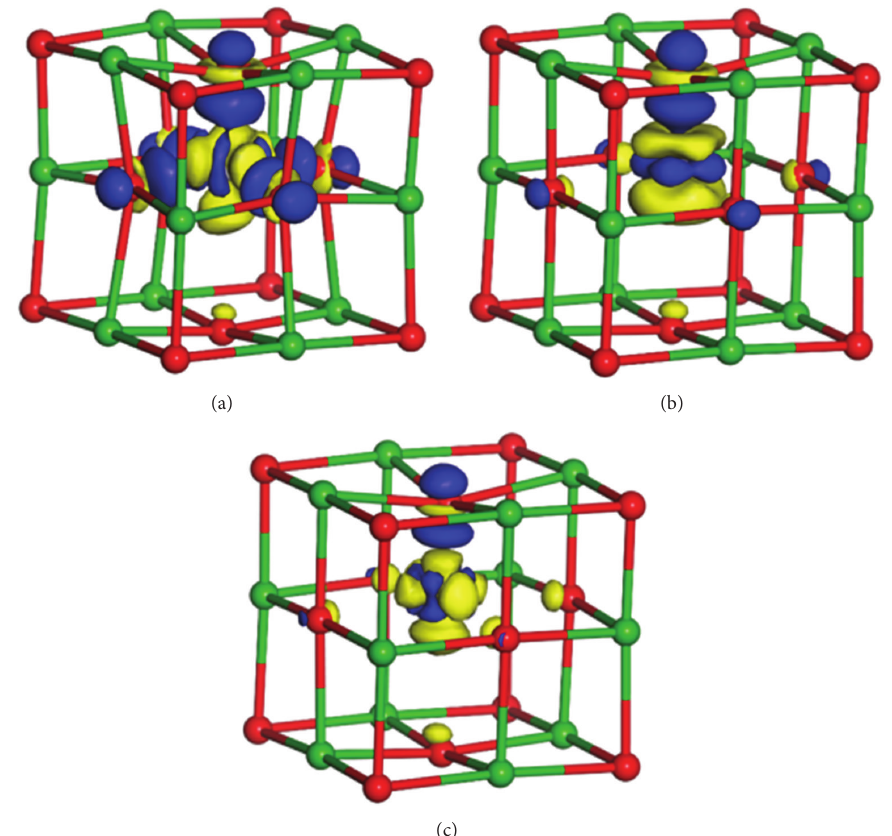
Figure 3: EDD for the V (a), Fe (b), and Ni (c) doped BaO(100) surfaces. The blue region corresponds to a density gain and the yellow region to a density loss. Oxygen atoms in red balls and metal atoms in green balls. For a better overview, only a 1 × 1 × 1 cell was used.